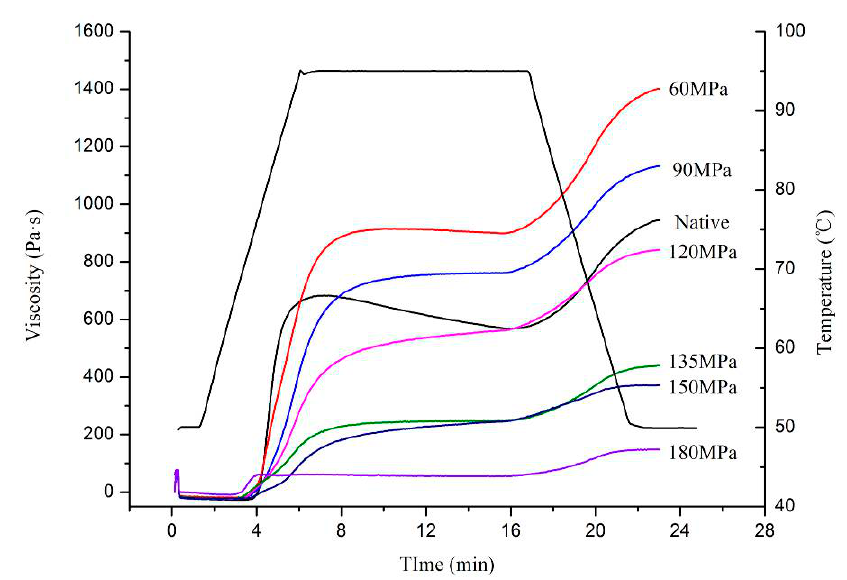
Figure 5. Pasting properties of native and pressurized LS.